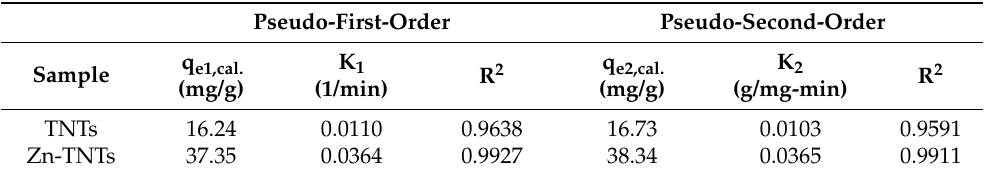
Table 1. Kinetics variables for the uptake of RhB using pseudo-first-order, and pseudo-second-order over TNTs and Zn-TNTs. Pseudo-First-Order